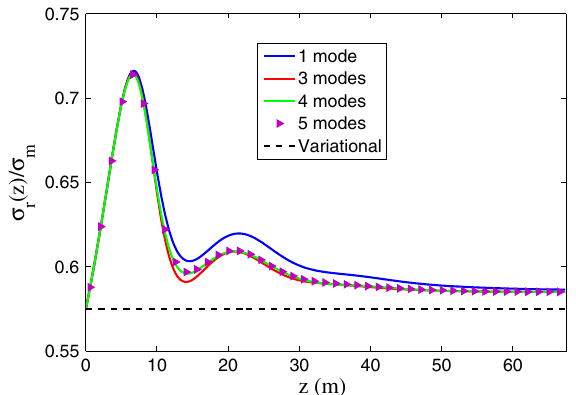
FIG. 4. Radiation beam size in units of (cid:9) numbers of expansion modes. Also shown is the variational estimate of the fundamental mode size (dashed